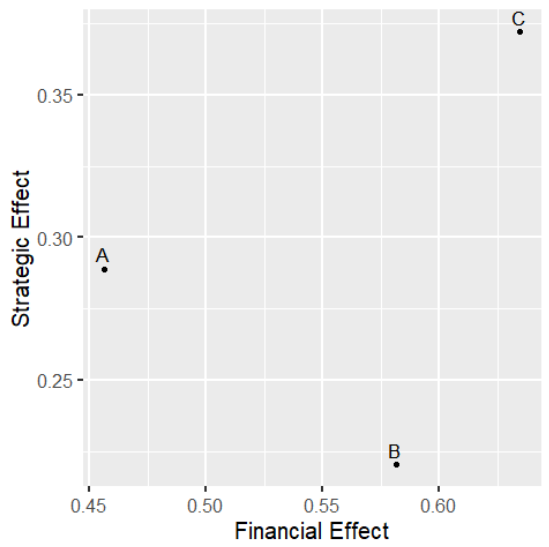
Figure 3. Fuzzy cognitive mappings (FCM) (linear threshold function): final states of Financial and Strategic Effects caused by Offers A, B, and C.